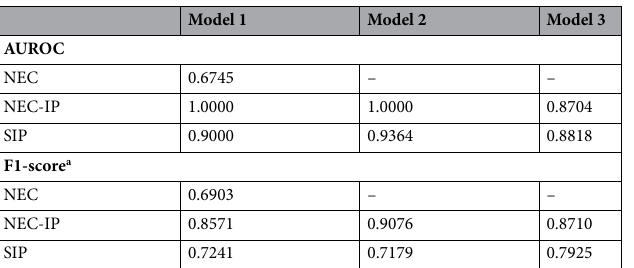
Table 4. Test results for 57 cases within a real NICU environment. NICU neonatal intensive care unit, AUROC area under the receiver operating characteristic curve, NEC necrotizing enterocolitis, NEC-IP intestinal perforation associated with necrotizing enterocolitis, SIP spontaneous intestinal perforation. a Scores were found with balanced validation dataset. Positive cases were